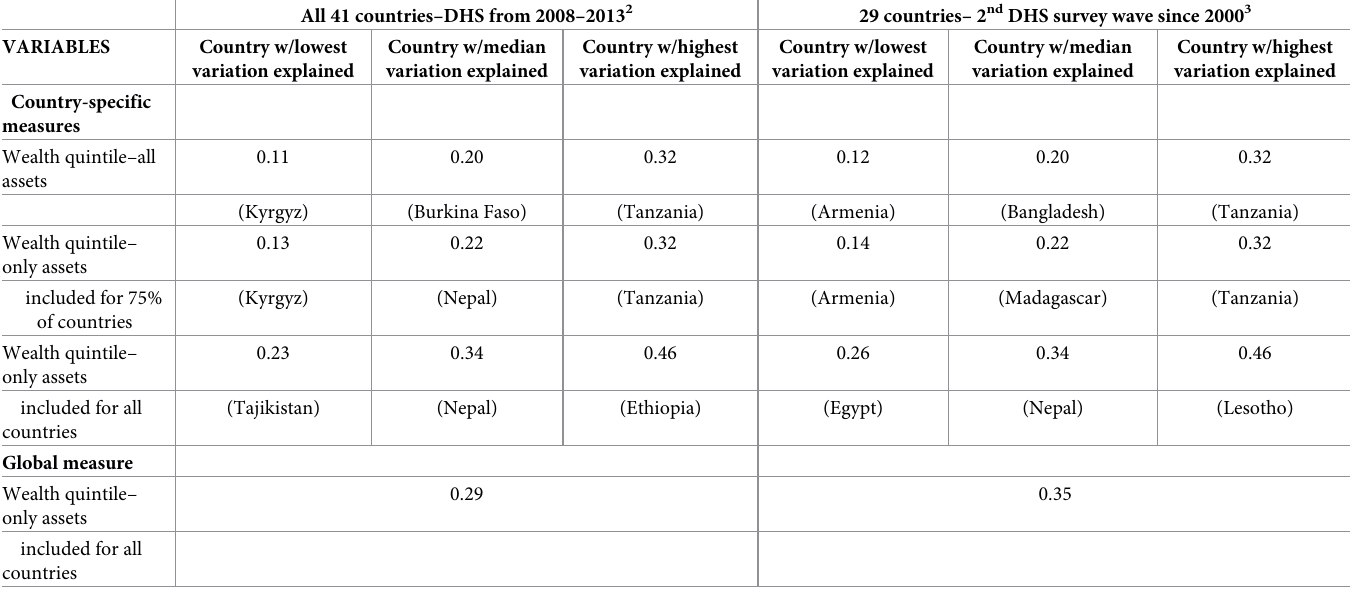
Table 2. Variation explained by the first principal component of each wealth index 1